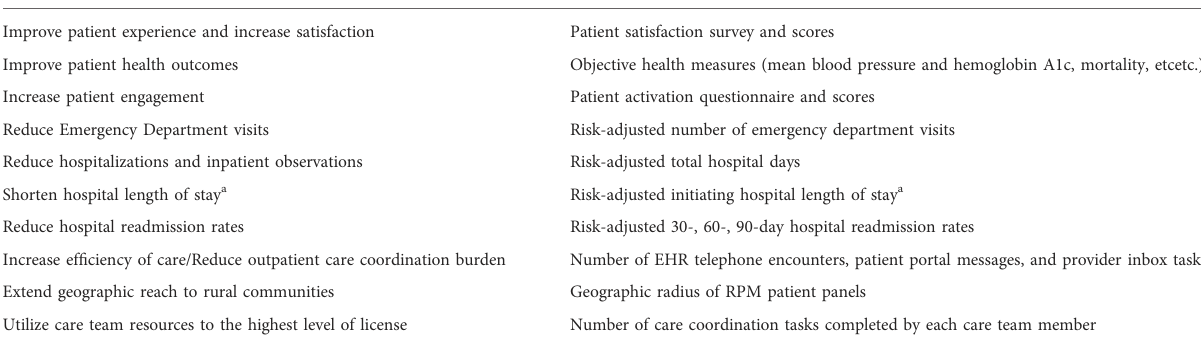
TABLE 1 Overall RPM program goals and corresponding metrics. RPM program goals